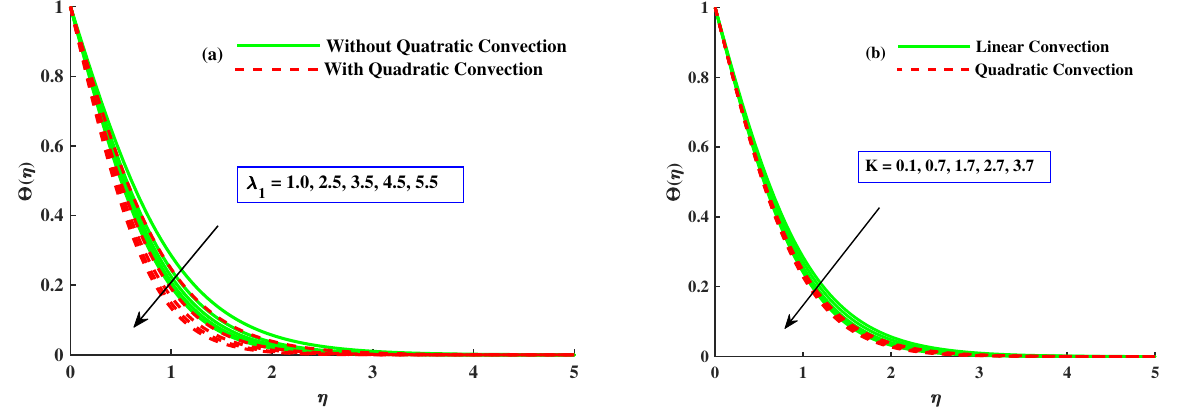
Figure 7. The influence of K & λ 1 on the Θ ( η )